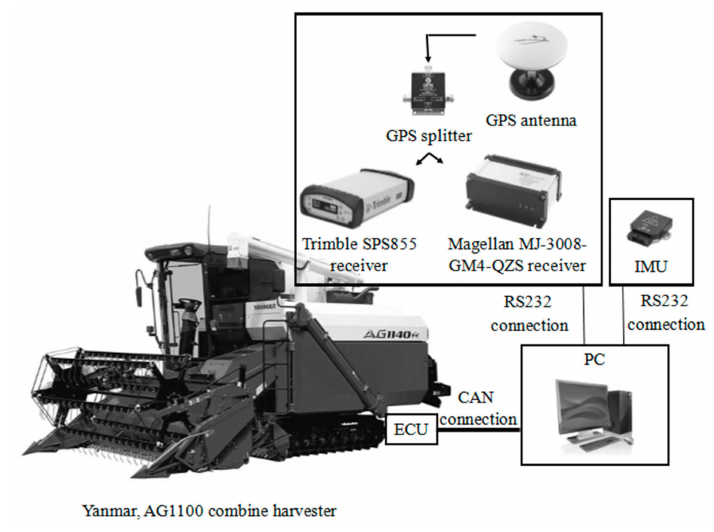
Figure 1. Platform of the study—AG1100 equipped with navigation sensor. Table 1. Specifications of the AG1100 combine